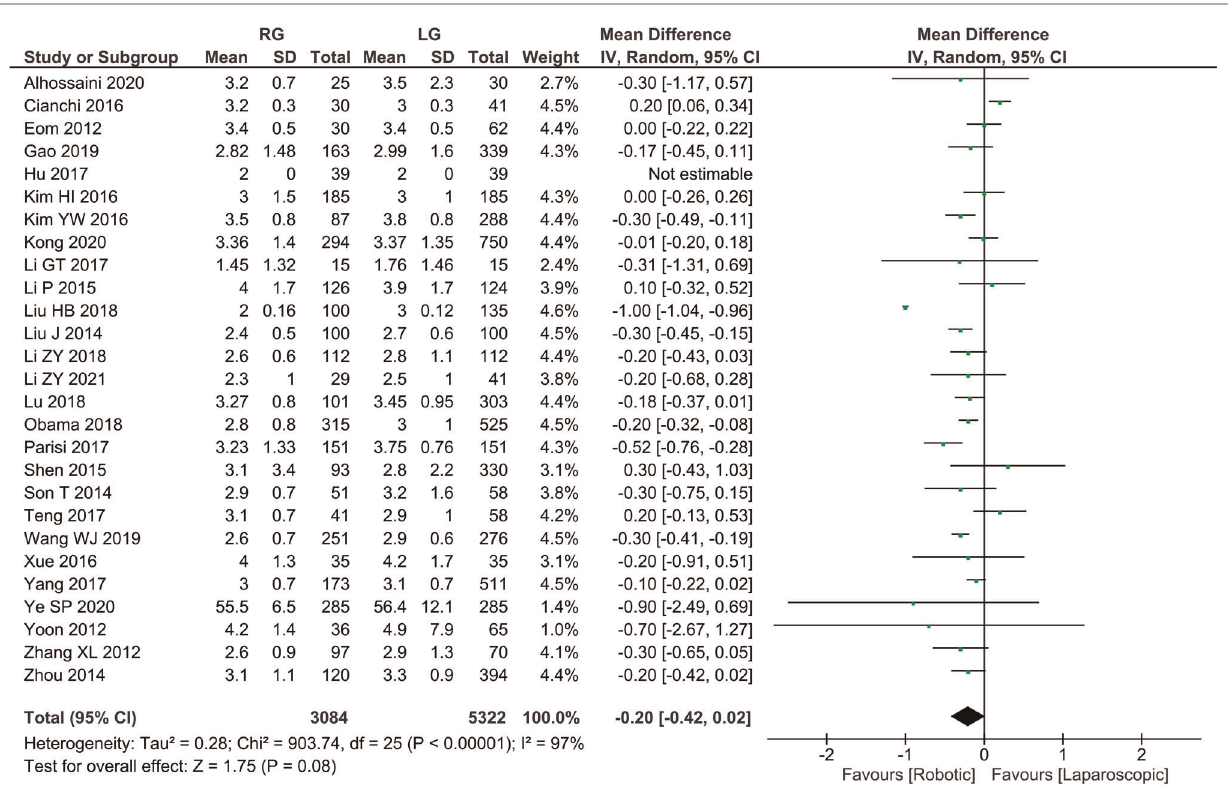
FIGURE 4 | Comparison of time to fi rst postoperative fl atus between RG and LG